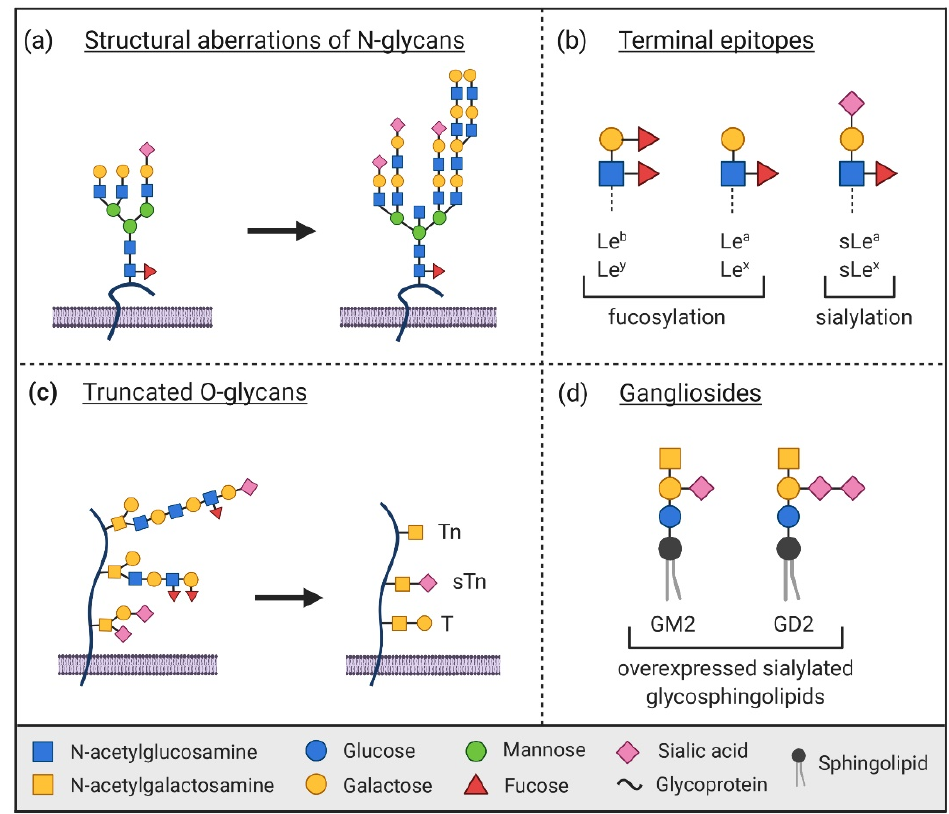
Figure 1. Common aberrations of glycan structures in cancer. ( a ) Altered and increased branching of N-glycans. ( b ) Capping of glycan structures with terminal epitopes such as the fucosylated Lewis (Le) antigen or sialylated structures like the sialyl Lewis (sLe) antigen. ( c ) Expression of truncated O-glycans like the monosaccharide GalNAc (Tn antigen), the sialylated Tn antigen (sTn), or the Thomsen Friedenreich antigen (T antigen). ( d ) Overexpression of gangliosides, a family of sialylated glycosphingolipids—for example, monosialoganglioside GM2 and disialoganglioside GD2. The figure was created with BioRender.com and is adapted from Mereiter et al., 2019 [10] .